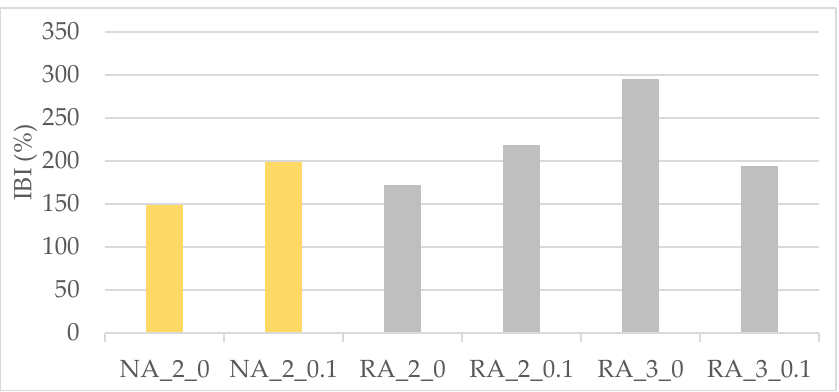
Figure 2. Immediate bearing index of the CBGM.